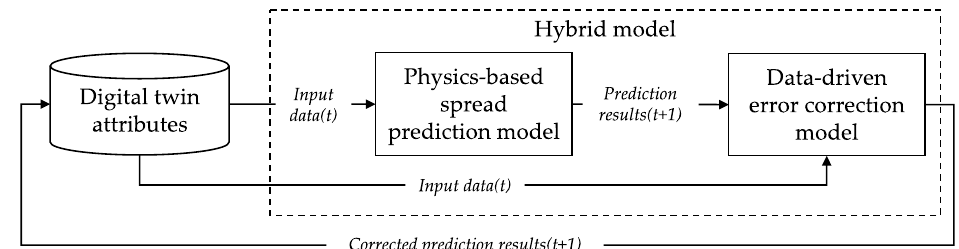
Figure 5. The data flow of the hybrid model for enhanced disaster spread prediction.